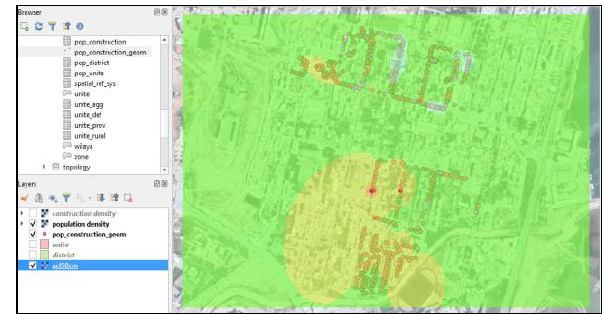
Figure 4. An example of an atlas of the " commune " object.